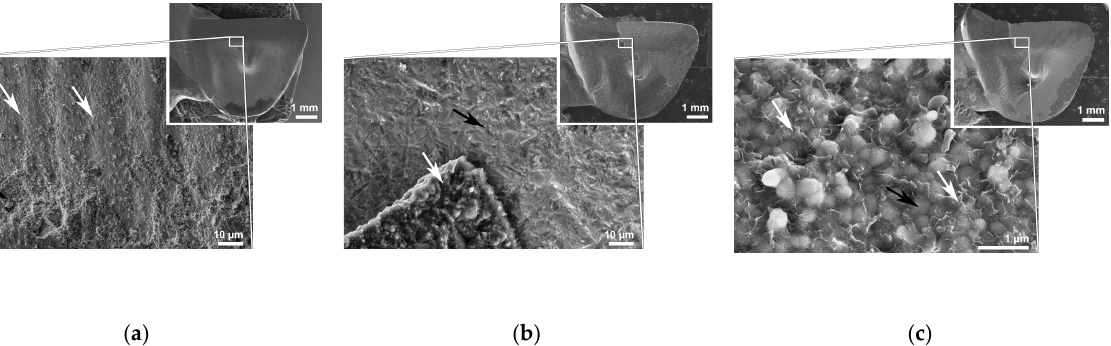
Figure 7. SEM micrographs of representative specimens for each experimental group after aging.